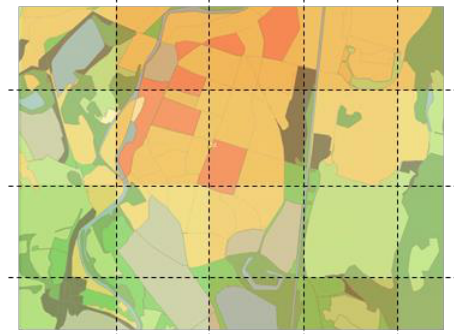
Figure 4. Example showing how MOD11-L2 pixels cover more than one